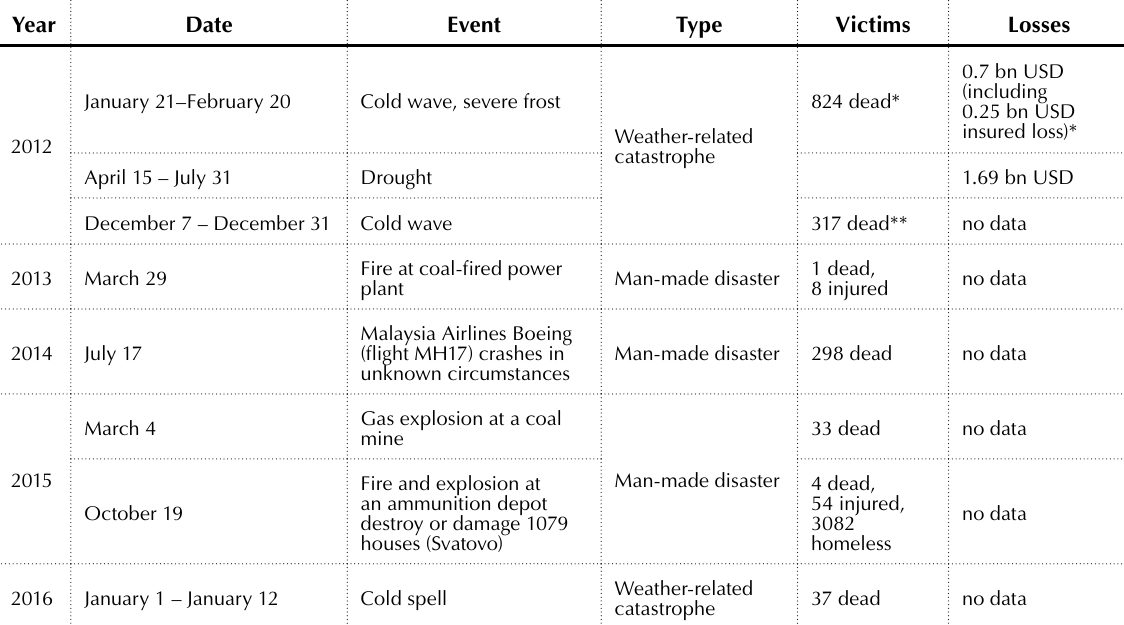
Table 2. The dynamics of vic�ms from natural and man-made disasters occurred in Ukraine from 2012 to